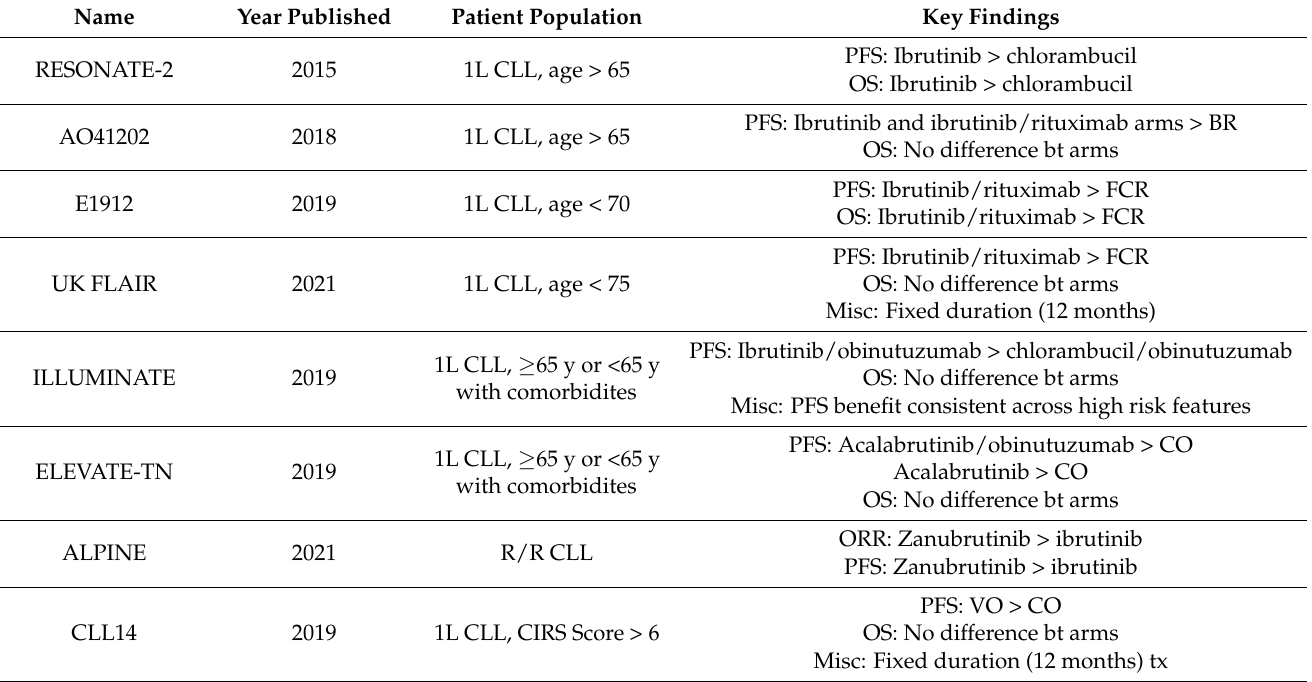
Table 1. A summary of key information from landmark CLL trials since